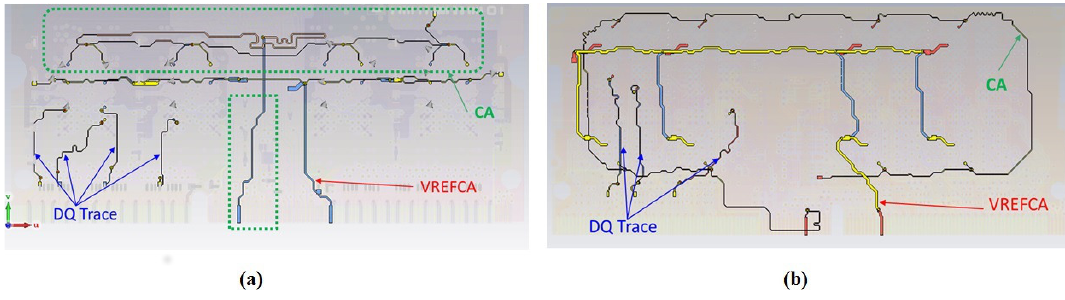
Figure 14. Internal routing mechanism of the DQ, CA and VREFCA nets on memory modules: ( a )